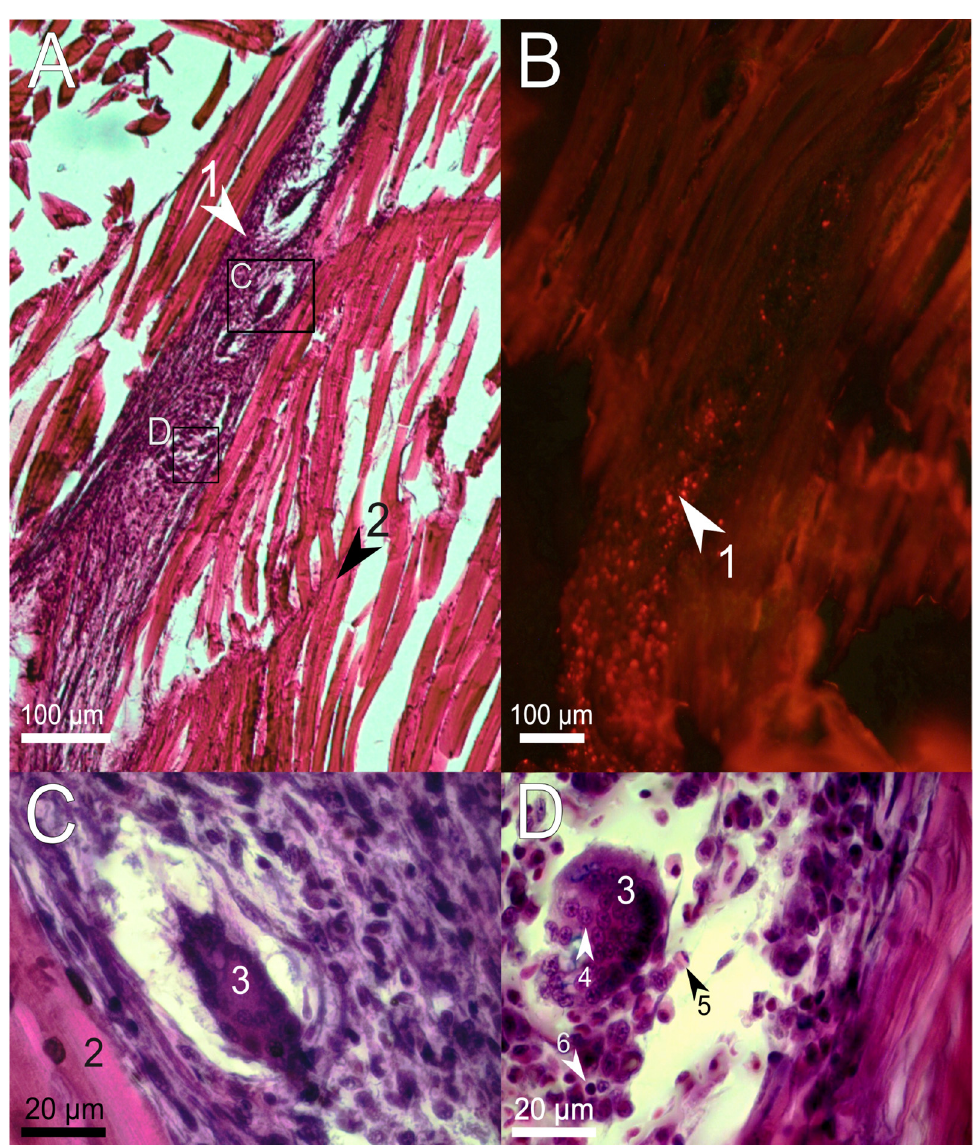
Figure 4. Sagittal histological section of D. rerio muscles 7 days after the injection of 2.7% PAAH + PMs. ( A ) histological section of the injection site (×10), H&E stain; ( B ) fluorescence of the unstained histological section in the red channel indicates microcapsules loaded with SNARF-1; ( C , D ) enlarged images of the region from A showing pieces of hydrogel surrounded by phagocytes; 1, PAAH + PMs; 2, intact muscle fibers; 3, granuloma formation; 4, monocyte; 5, eosinophil; 6, lymphocyte.